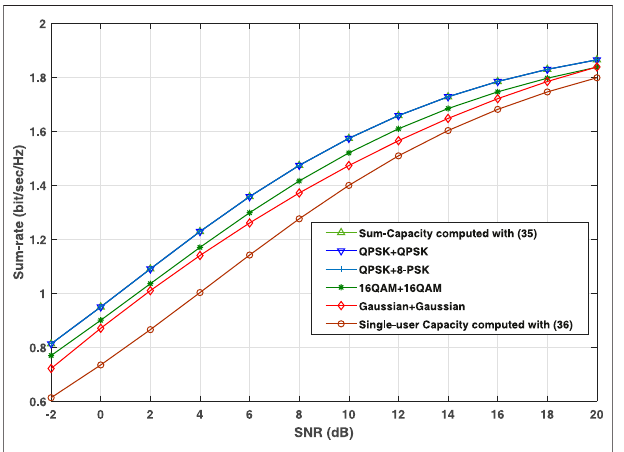
FIGURE 4 | Sum-rates achieved by different pairs of input signals and Single-usercapacityoverthe3-termGMMAC.Thetwousersareassumedto